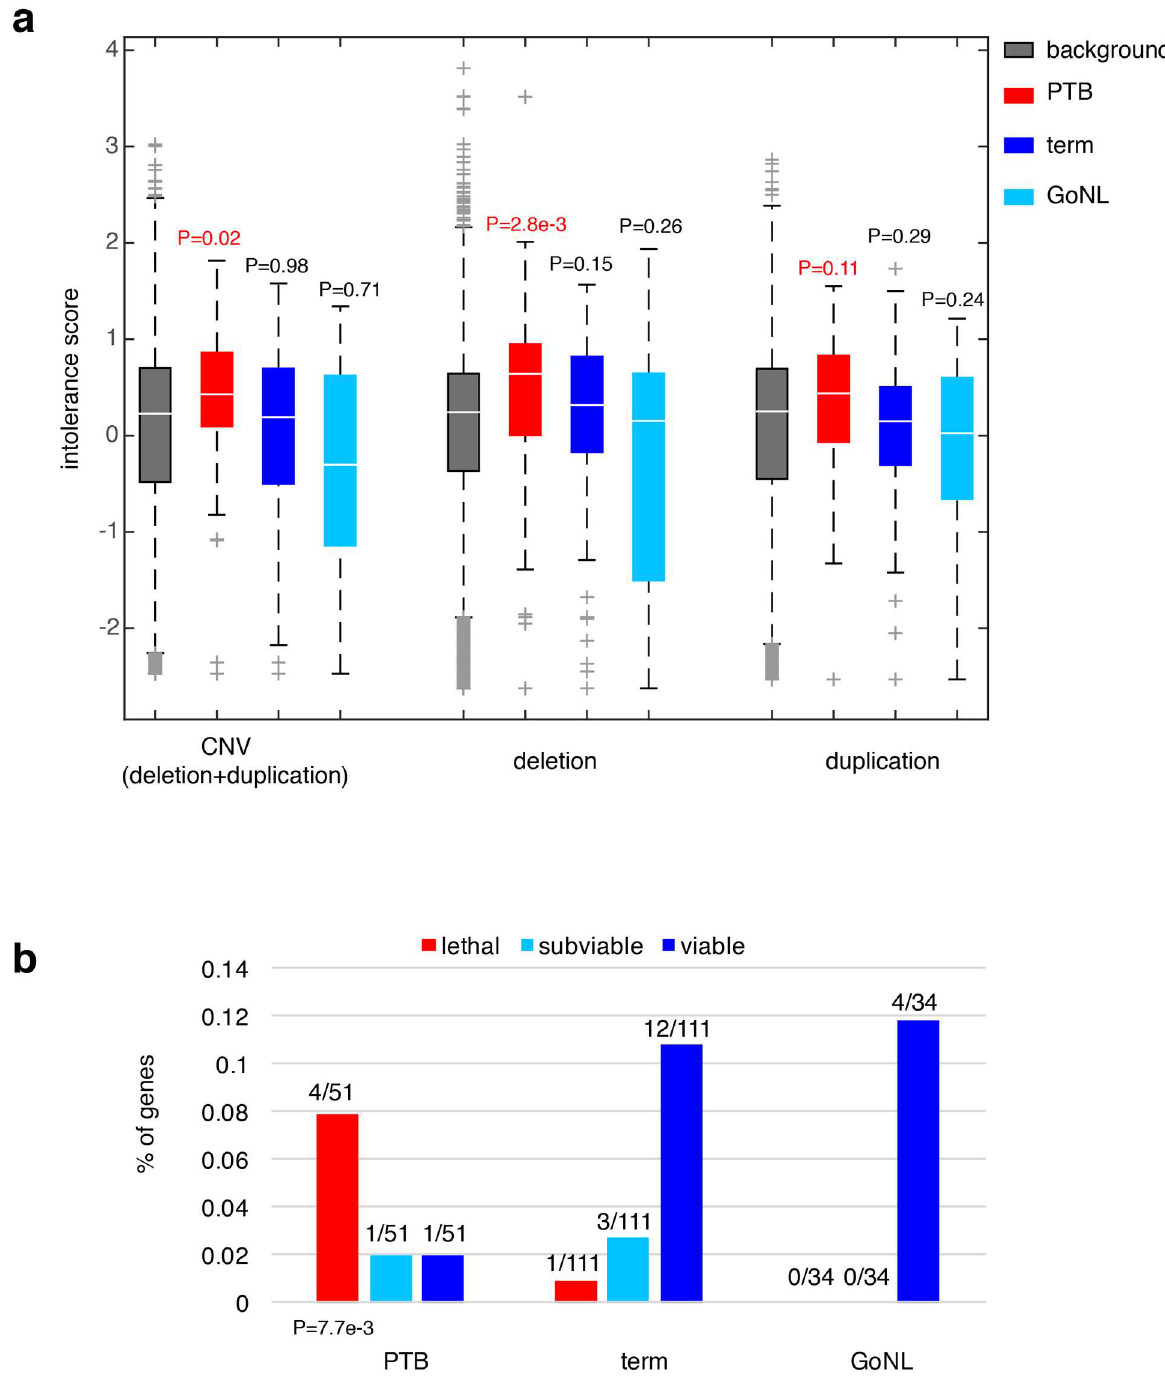
Fig 3. Characterization of the PTB genes. (a) Referencedwith the genome background, the PTB gene set displayeda significant increase in their intolerance to copy number variations, particularlypronounced to deletionevents, but not to duplication events. The same pattern was absent from the term gene set as well as from the GoNL genes. Referencedwith the genomebackground, P values were calculatedbasedon the Wilcoxon rank-sum test. (b) The percentages of lethal, subviableand viablegenes in PTB, term and GoNL gene sets. The PTB set was significantly enrichedfor genes whose mouse orthologs are embryonicessential(i.e. homozygous knockoutsdisplayedembryonic lethalphenotypes), whereasthe term and GoNL genes had more viable genes(i.e. homozygous knockoutsare viable). The P value was computedusing the Fisher’s exact test by comparing the proportionof essentialand viable genes in the PTB and term sets. Note that the GoNL set had no lethal and subviablegenes.